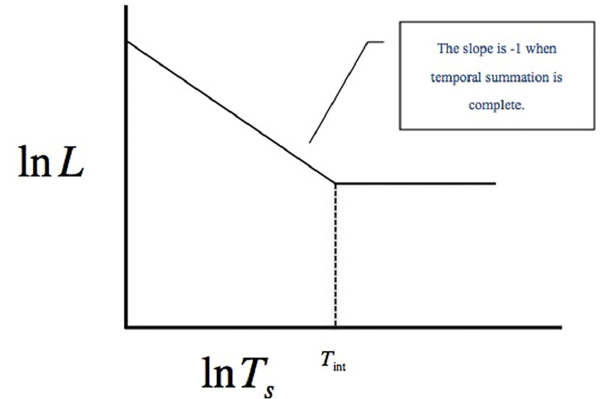
Fig 1. ln L vs. ln T s . The relationship between the luminance, L , and the duration of the stimuli, T s , plotted as ln L vs. ln T s .